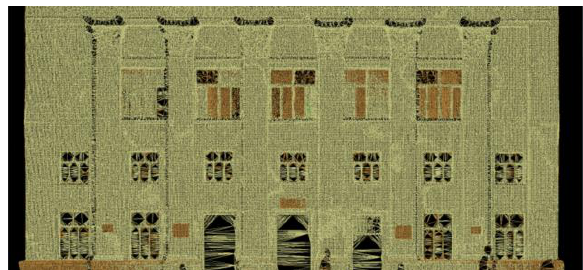
Figure 5. The three-dimensional façade model from images